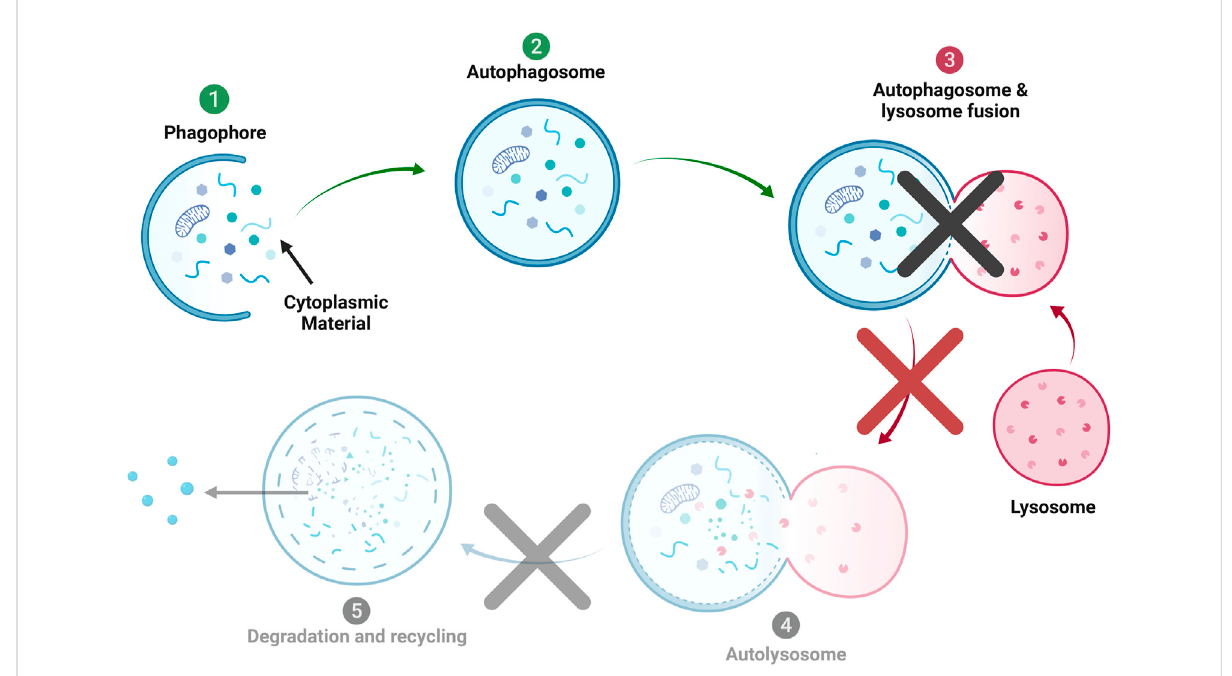
FIGURE 1 AutophagicProcessinLysosomalstoragedisorders(LSD).InmanyLSDsdiseases,lackofautophagosome-lysosomefusionisbelievedtobethe main cause of autophagic failure and